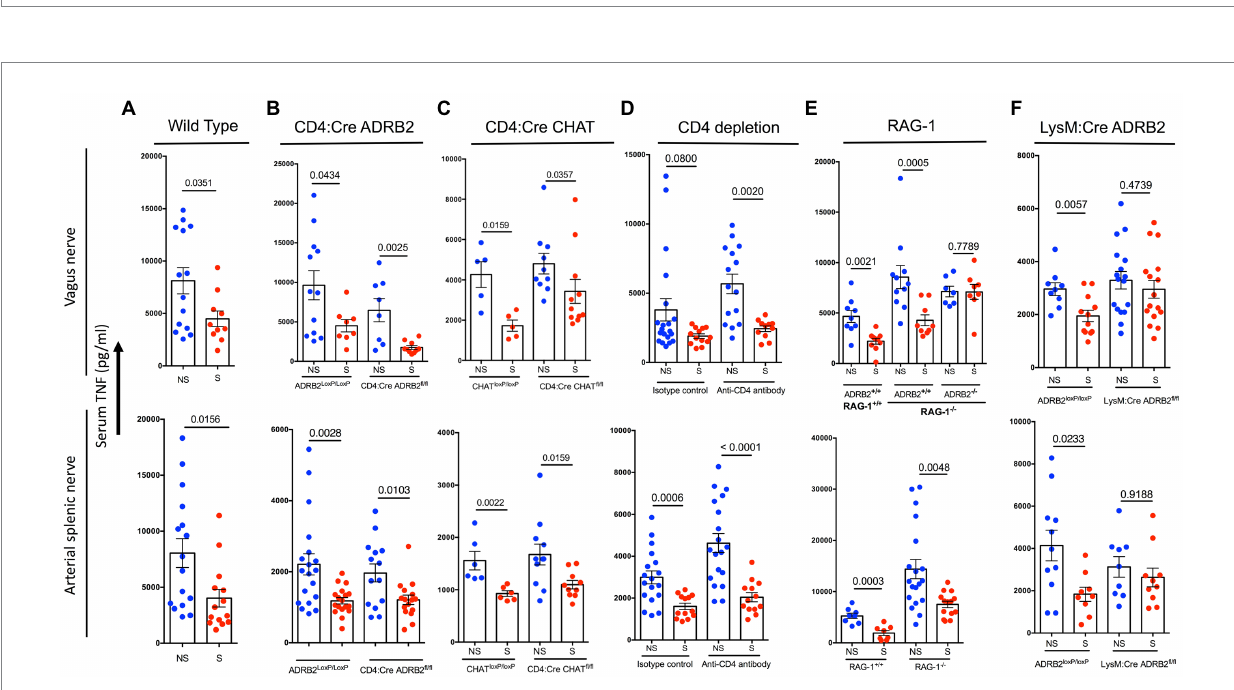
FIGURE 2 Cholinergic anti-inflammatory pathway is independent of CD4+ T-cells in mice. Wild type (A) , CD4:Cre ADRB2fl/fl (B) , CD4:Cre CHATfl/fl (C) mice and LysM:Cre ADRB2 fl/fl (F) mice carrying (fl/fl) or not (LoxP/LoxP) the Cre transgene and RAG-1 − / − (E) mice and control littermates were implanted onto the vagus or main arterial splenic nerve with a micro-cuff electrode 1 week before electrostimulation was applied. (D) Wild type mice were i.p. injected with CD4 depleting antibody or isotype control on day − 3 and − 1 relative to electrostimulation. One week after surgery, LPS (5 mg/kg) was injected and electrical stimulation was applied or not (650 μ A, 10 Hz, 2 min duration, − 20, 0 and + 10 relative to LPS injection) to the vagus (upper panels) or main arterial splenic nerve (lower panels) in freely moving animals. Data show serum TNF levels in individual mice ±SEM of 2–5 experiments in non- electrically stimulated (NS, blue) and electrically stimulated (S, red) mice. (A–F) Mann–Whitney were performed. * p < 0.05; ** p < 0.01; *** p < 0.001; **** p <